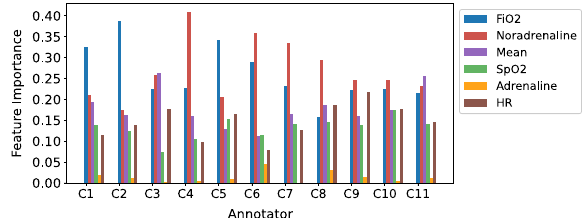
Fig. 4 Feature importance distributions across the Random Forest models, trained on the 11 consultants ’ (C1 – C11) QEUH annotated datasets. The x -axis lists the 11 classi fi ers and the y -axis is the importance value with a range from 0 to 1, where 1 denotes the largest